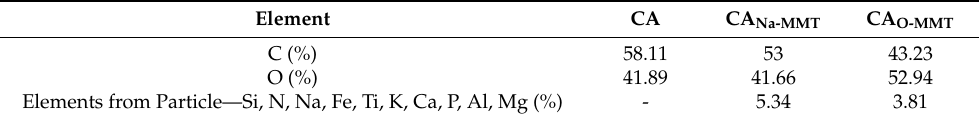
Table 1. Surface elemental composition of the membranes using XPS analysis.